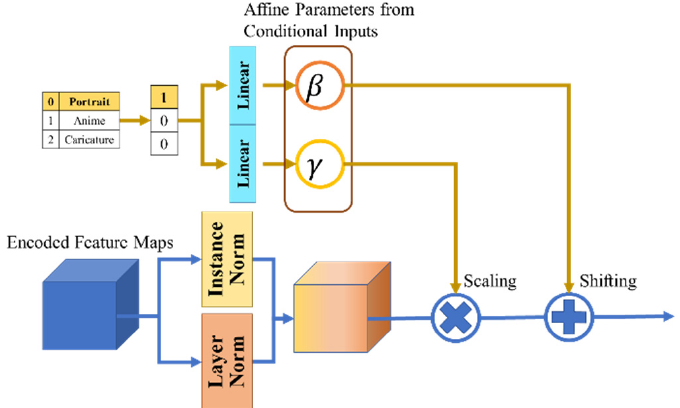
6 Figure 2. Overview of the discriminator in the Multi-CartoonGAN. In the training phase, 𝐺 outputs the translated image 𝐺(𝑥, 𝑐) by following the con- tent of conditional vector 𝑐 . Meanwhile, 𝐷 outputs the feature map, the CAM logit, and the classified units. Discrimination is performed on the feature map patches to determine whether the input image is from the real artistic domain images or a fake translated image from 𝐺 . Discrimination is also performed on the CAM logit from the attention feature maps via the adaptive pooling layers. The classified units provide the criteria that deter- mine the artistic style that the input image belongs to. 3.2. Conditional Adaptive Layer-Instance Normalization in the Generator As pointed out in [25], conditional input injections directly into the generator can lead to unstable conditional training. To address this problem, a conditional vector is em- ployed as the layer hyperparameter in our generator. This idea was inspired by AdaLIN [6], which controls the affine parameters so that scaling and shifting through the extracted feature maps is performed by the adaptive max-pooling of the adaptive average pooling layers. Our results suggest that, assuming that a different input for the fully connected